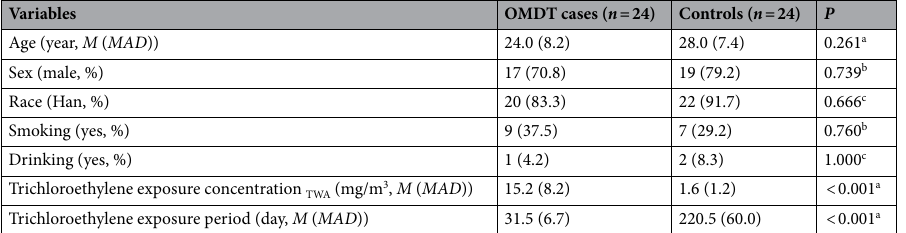
Table 1. Baseline characteristics of the study subjects. OMDT, occupational medicamentosa-like dermatitis due to trichloroethylene; M, median; MAD, median absolute deviation; TWA, time weighted average. a Mann– Whitney U test. b χ 2 -test. c Fisher’s exact